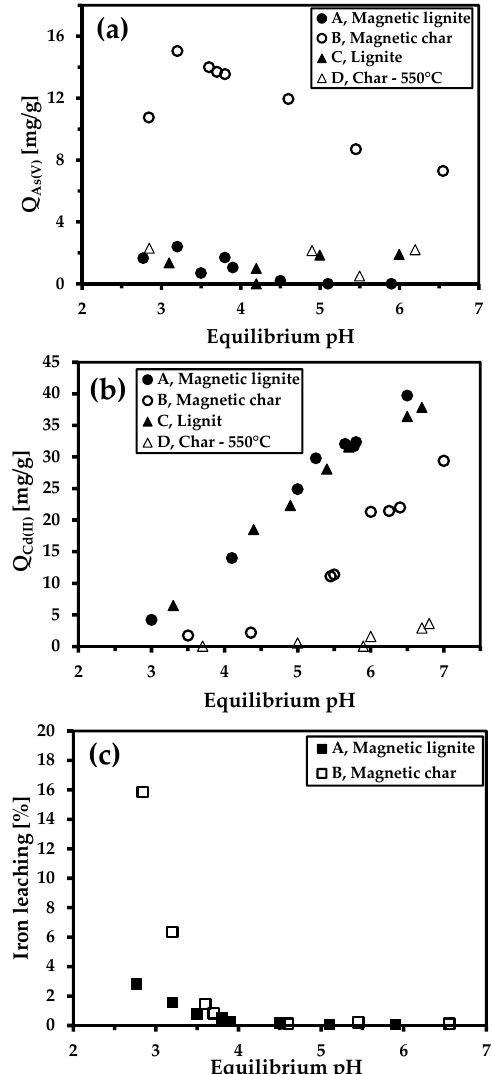
Figure 7. Sorption capacities of the sorbents towards As(V) ( a ) and Cd(II) ( b ) at various pHs. Iron leaching during the sorption of As(V) at various pHs ( c ). Conditions: batch-type system; c(sorbent) = 2 g/L; c 0 (As(V)) = 98.6 mg/L; c 0 (Cd(II)) = 92 mg/L; room temperature; 24 h.